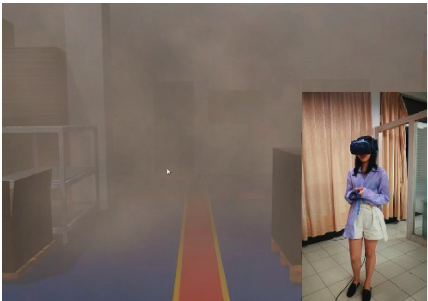
Figure 11: A participant is experimenting in the VR fire